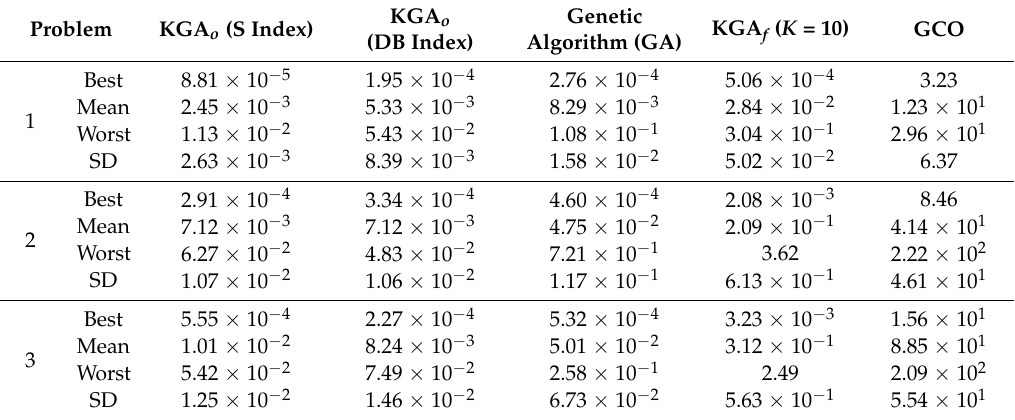
Table 2. Comparison of statistical results of four algorithms for test problems 1–7 of dimensions D = 10.